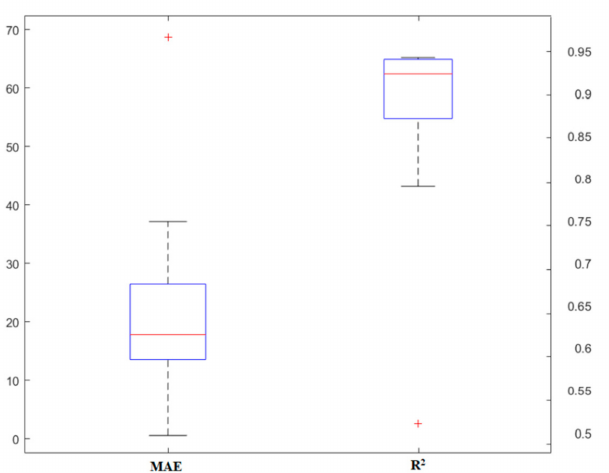
Figure 6. The result of the classification and regression trees (CART) model, based on the tree